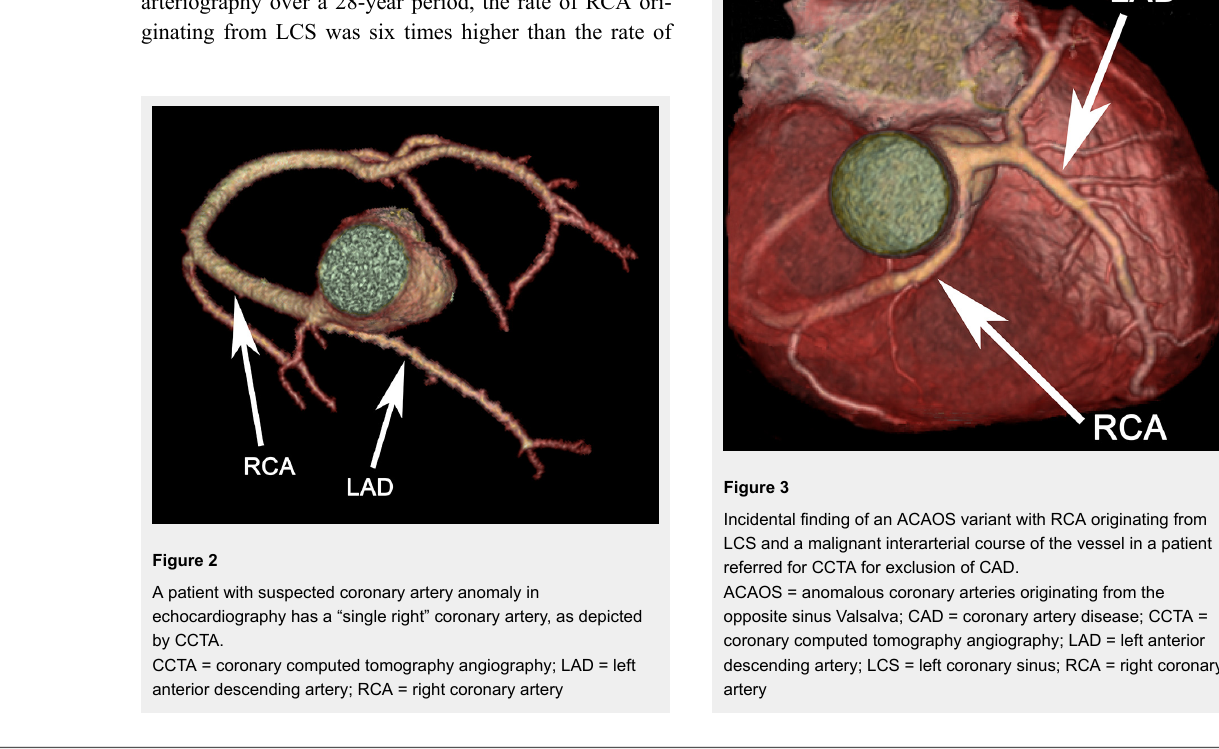
Table 2: Patient